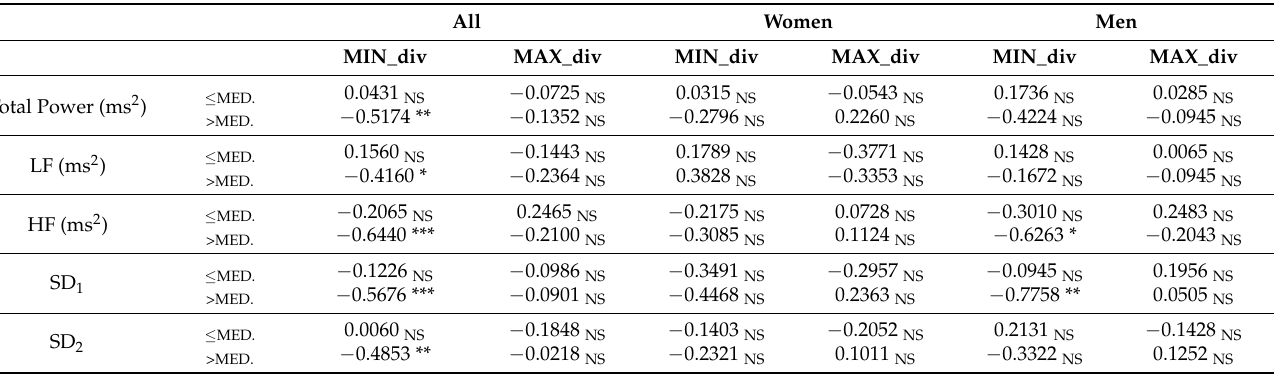
Table 8. Correlation coefficients between MIN_div; MAX_div and the selected parameters of HRV in the frequency domain.